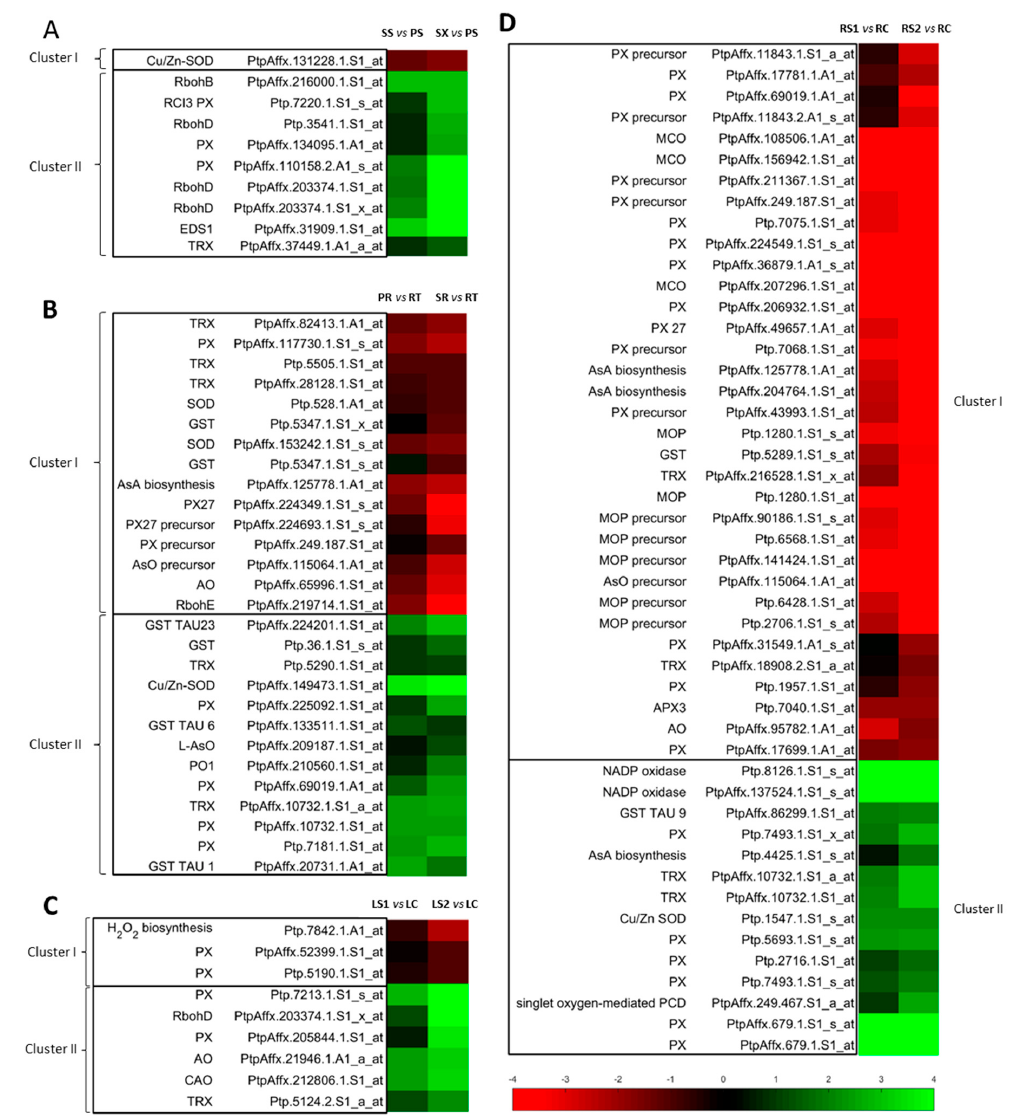
Figure 1. Heatmaps of the expression profiles of Populus trichocarpa genes related to reactive oxygen species (ROS) metabolism during primary and secondary growth of ( A ) stems and ( B ) pioneer roots, and during the senescence of ( C ) leaves and ( D ) fine roots.